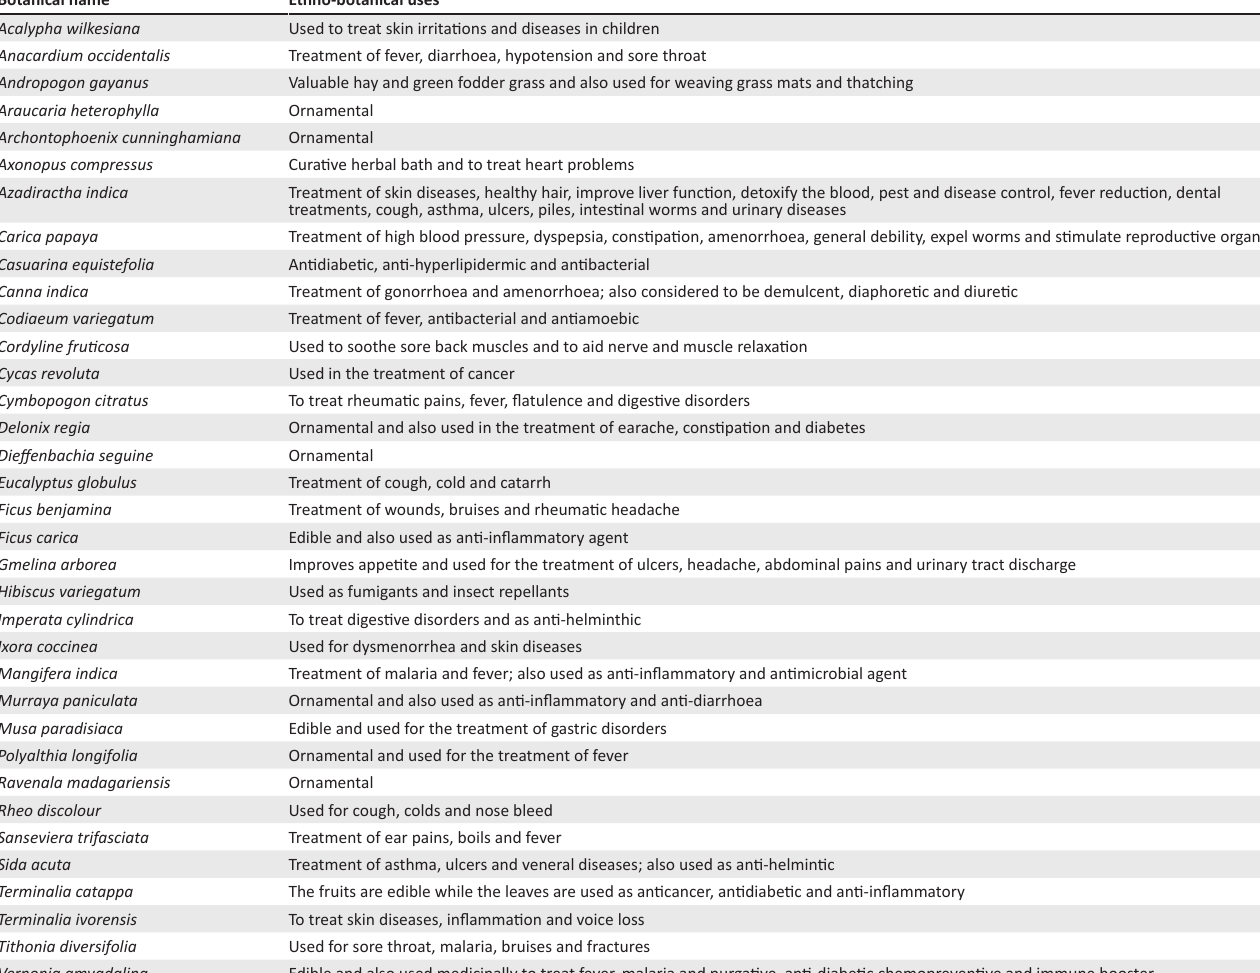
TABLE 5: Ethnobotanical uses of identified plant species in Lagos State University campus. Botanical